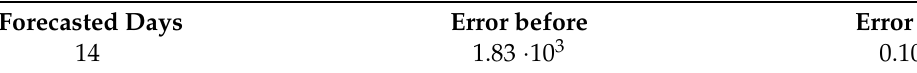
Table 3. Errors before and after the optimization